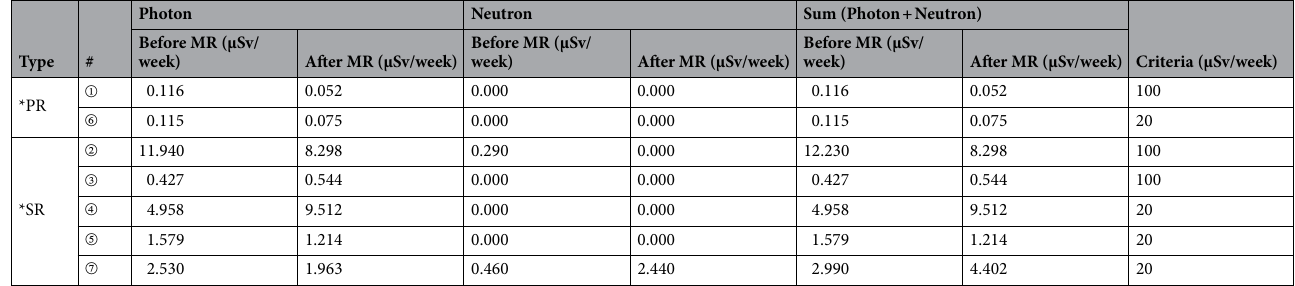
Table 1. Comparison between leakage doses before and after applying 1.5 T MR. The numbers indicate measurement positions shown in Fig. 6. PR primary radiation, SR secondary radiation.